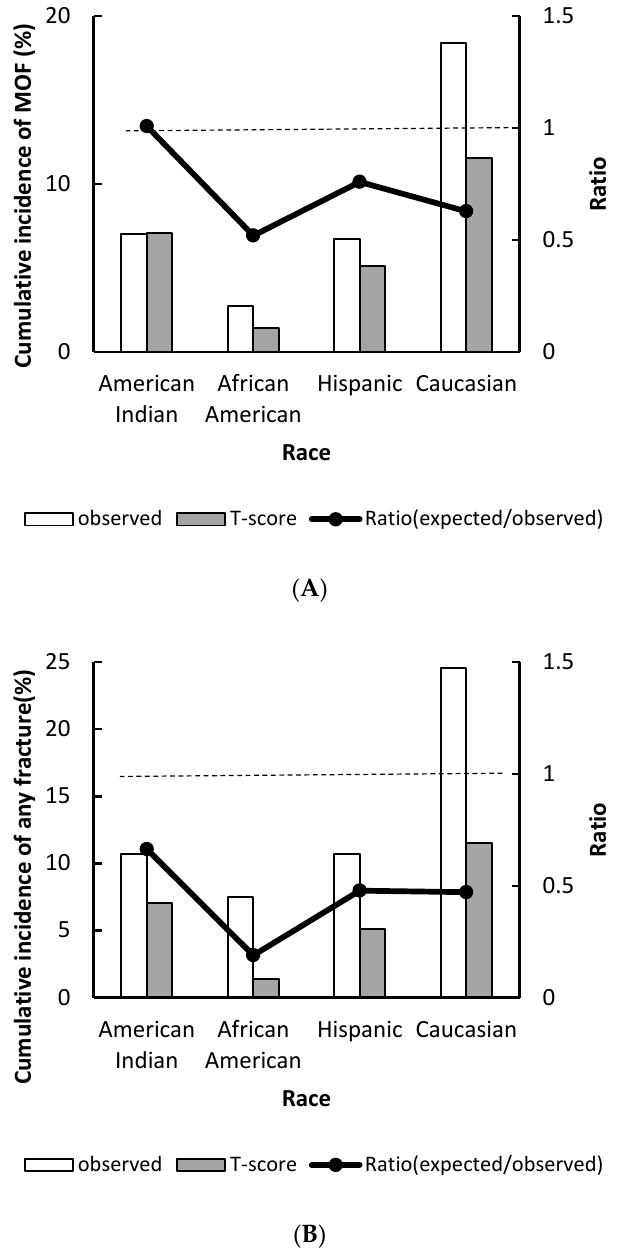
Figure 2. Observed versus predicted major osteoporotic fracture ( A ) and any fracture ( B ) probability stratified by race. The dotted line indicates a relative ratio of 1 (reference line), ratio < 1 indicates that T-score underestimates fracture